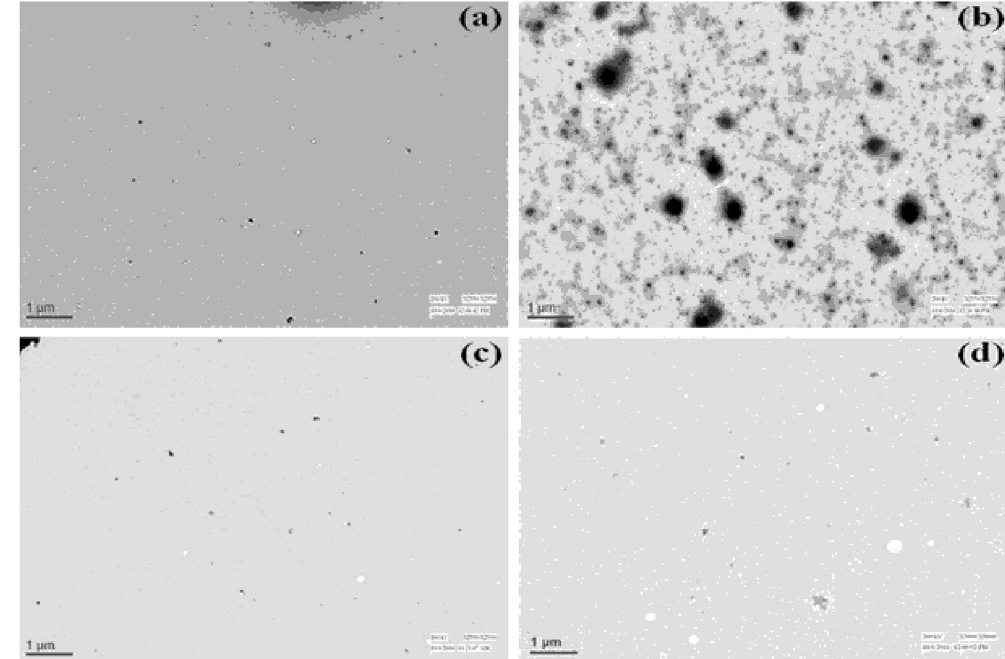
Figure 4. TEM (transmission electron microscopy) of α -casein in presence of TMAO, sarcosine, and betaine. α -casein incubated overnight in the absence ( a ) and the presence of TMAO 1 M ( b ), sarcosine 1 M ( c ) and betaine 1 M ( d ). The scale bar is 1 µ m. Data was collected 16 hour after sample